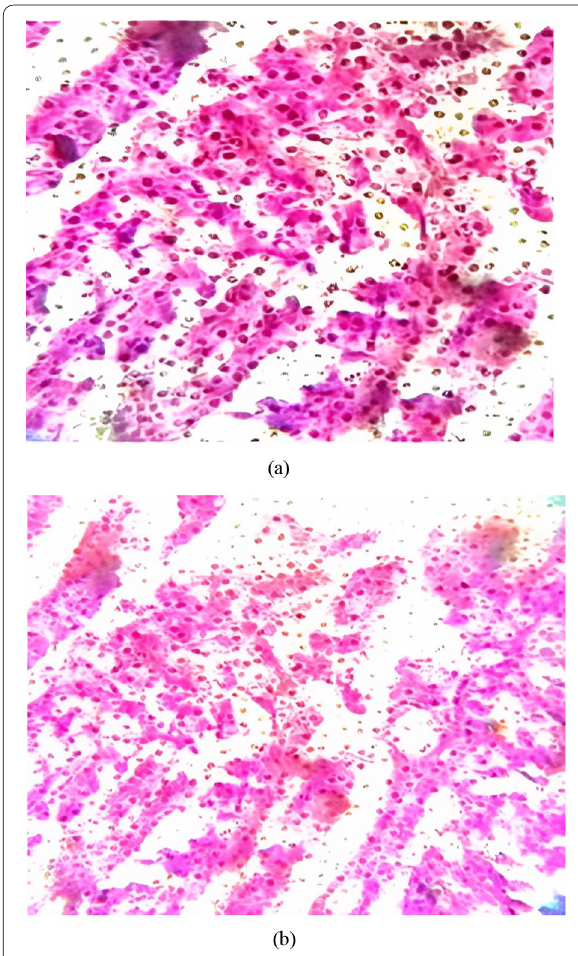
Fig. 7 Histopathological study of colon a experimental animal treated with satranidazole raw drugs b experimental animal treated with test formulation of satranidazole